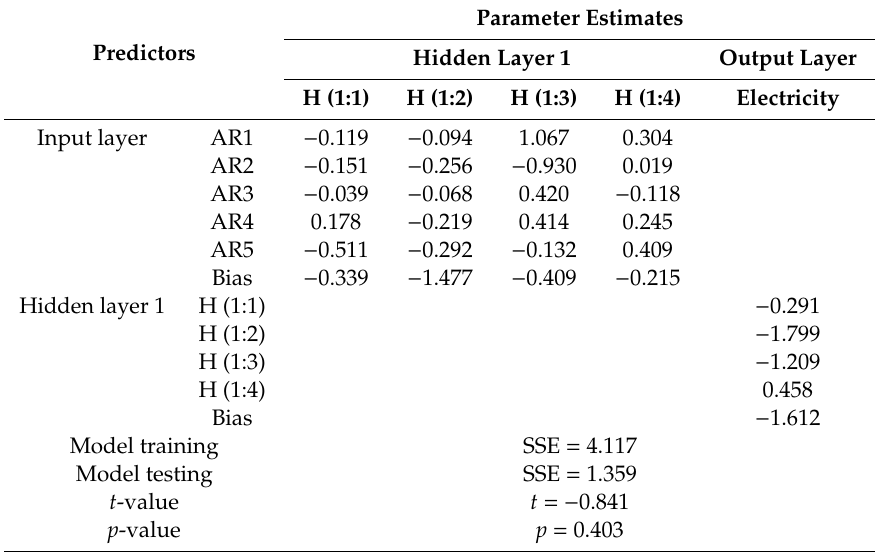
Table 6. The final ANN model summary for electricity consumption in the residential sector.